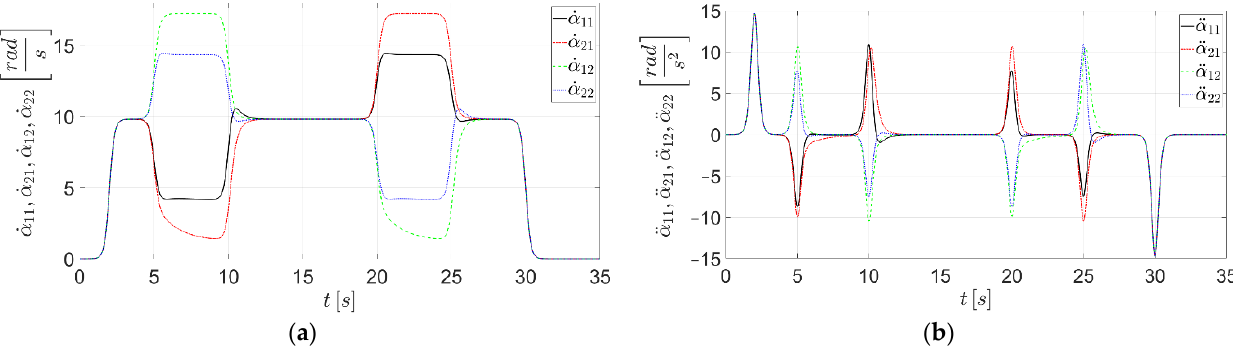
Figure 5. ( a ) Angular velocity of the wheels driving the robots, and ( b ) angular acceleration of the driving wheels.